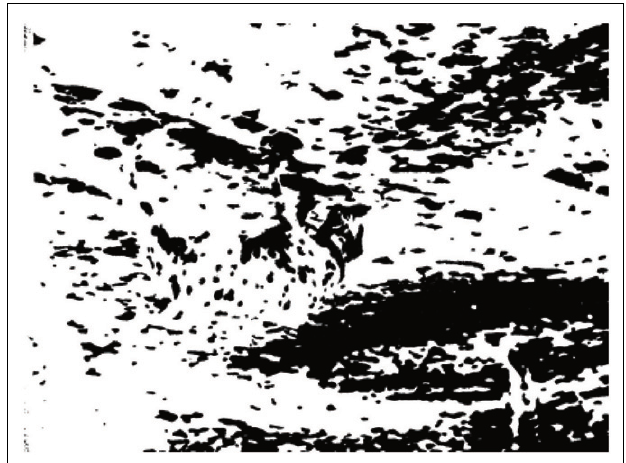
FIGURE 1 |A familiar, but camouflaged object (readers experiencing difficulty in recognizing the Dalmatian dog may wish to view the picture upside-down). Photo courtesy R. C. James. Reprinted from Lindsay and Norman (1977), with permission of authors and